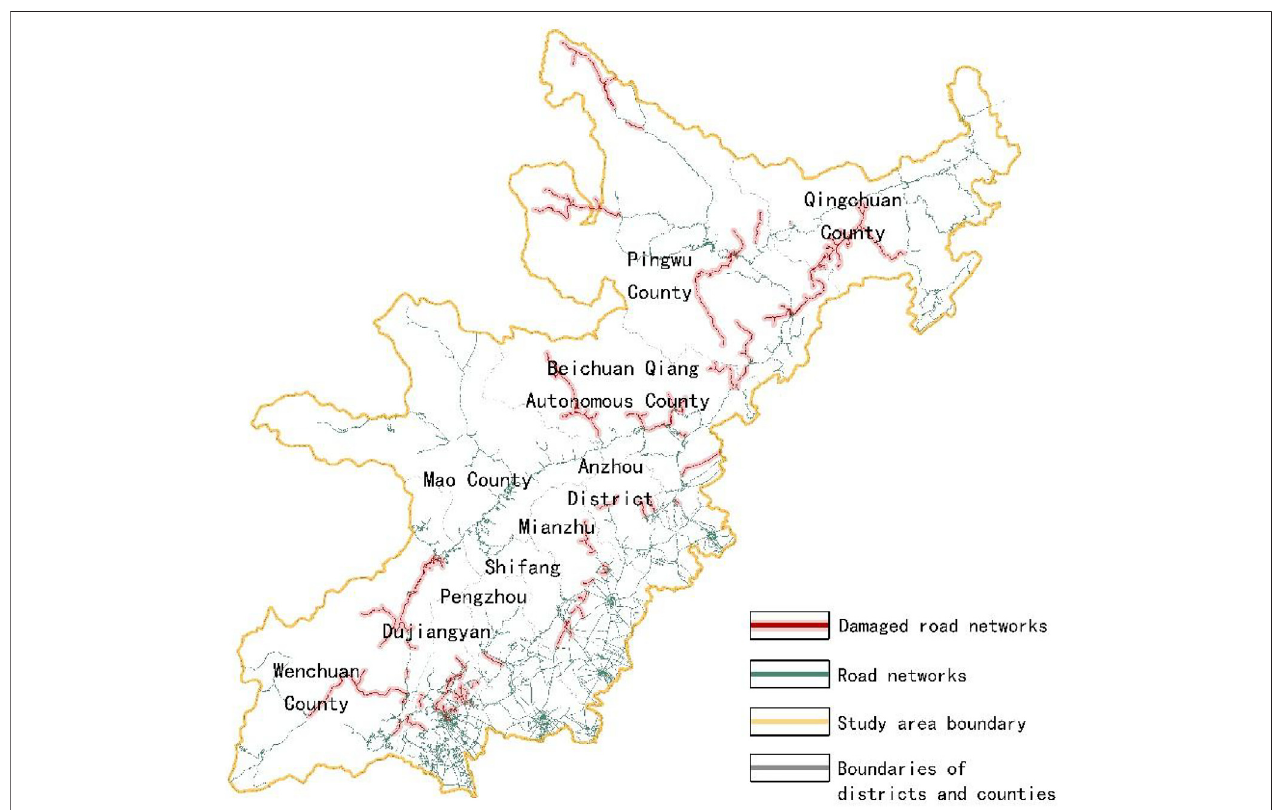
FIGURE 6 | Schematic representation of the damaged road network when repaired during full-scale rescue.